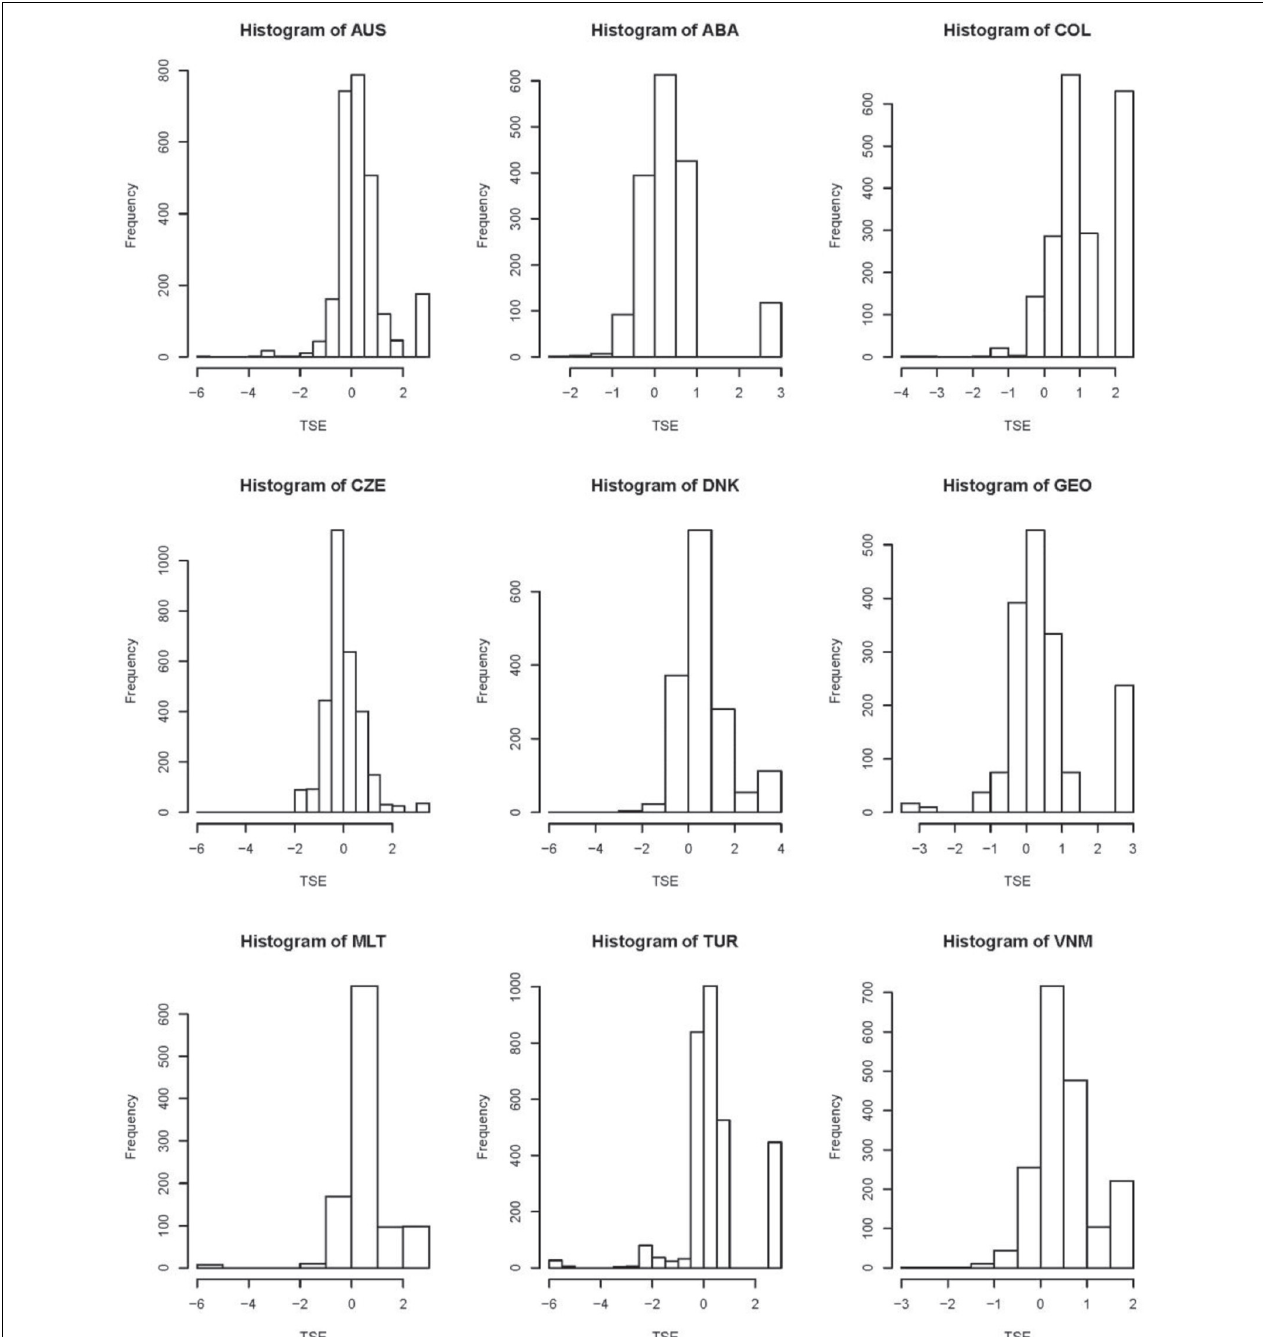
FIGURE 3 | Histogram plots of latent traits (LTs) measured teacher self-efficacy (TSE).